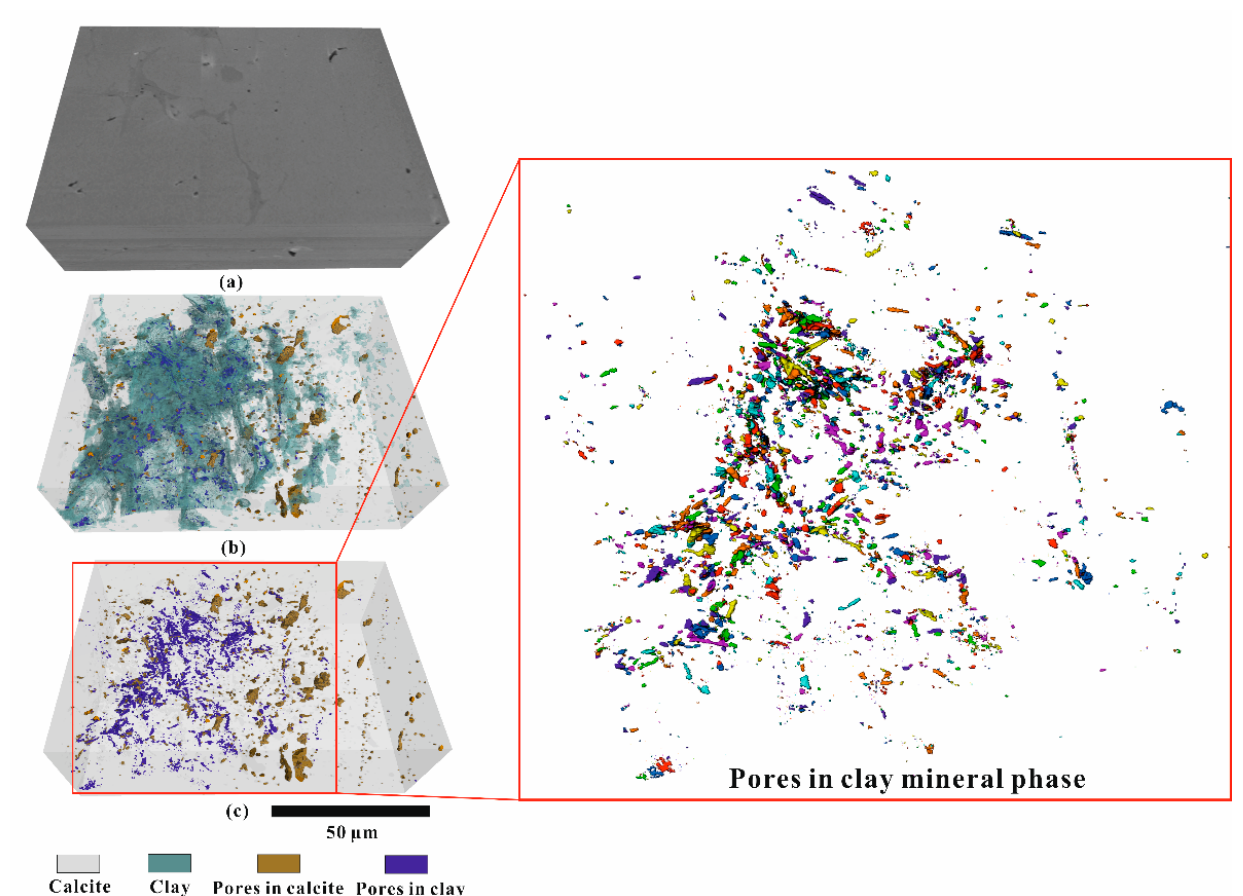
Figure 10. Dragonfly’s deep learning segmentation results for the FIB-SEM image stack: ( a ) original greyscale 3D rendered structure of FIB-SEM image stack (10 nm voxel size); ( b ) clay mineral phase (green) is separated from calcite phase (white), and pores in calcite (gold) and pores in clay (blue) are segmented; ( c ) 3D distribution of pores in clay and calcite. Neither pores in the calcite nor the clay mineral phase are connected (different colors in the magnified zone are used to differentiate adjacent pores in clay).